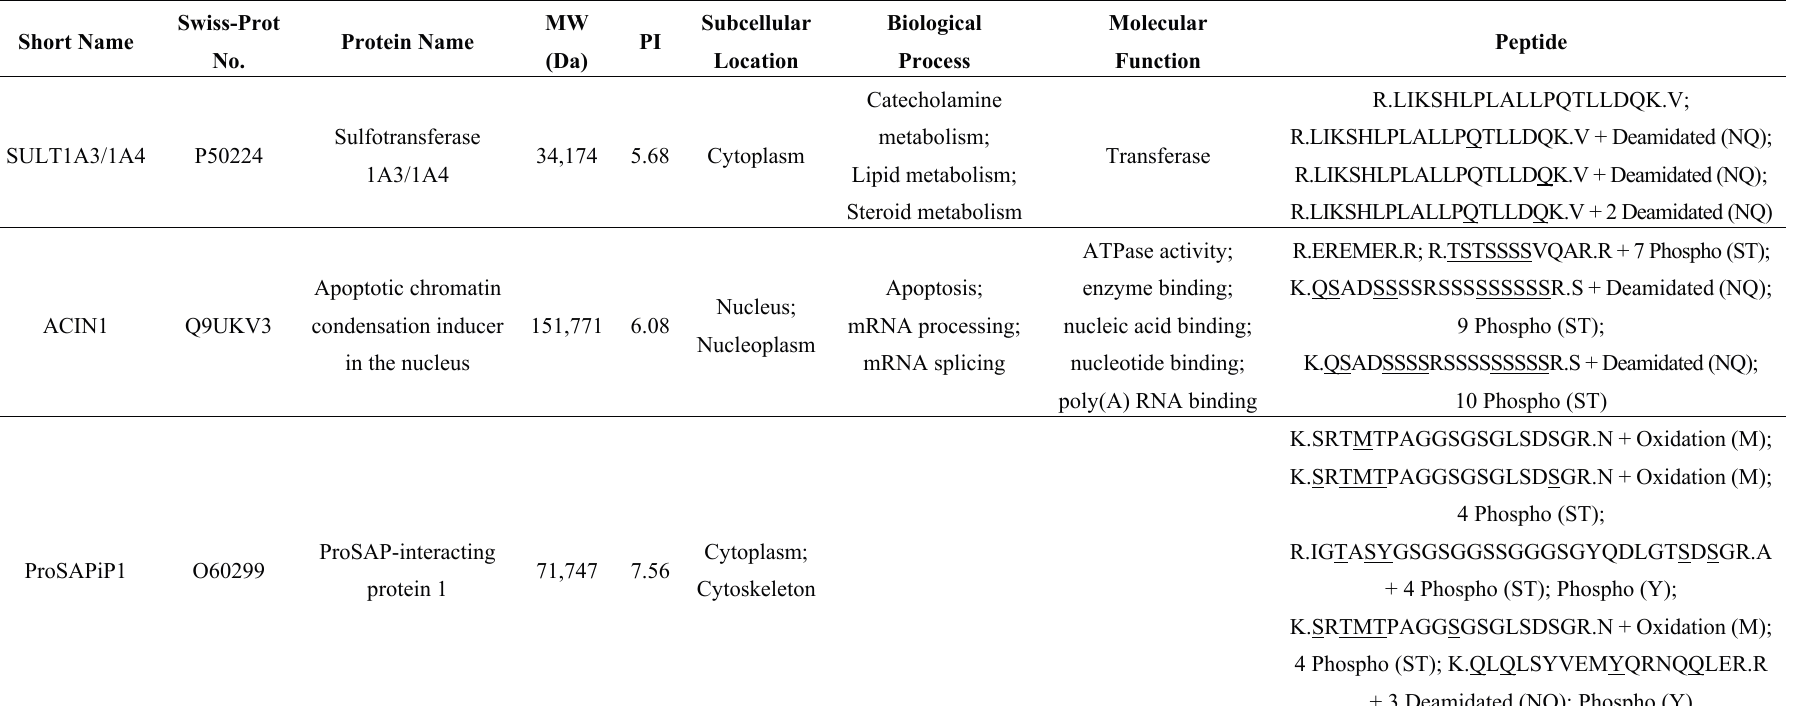
Table 2. The nine unique proteins identified by the higher confidence level (at least three unique peptide sequences matched) with significant difference between CCL-13 and HepG2 cells incubation with SF-CSNPs in this